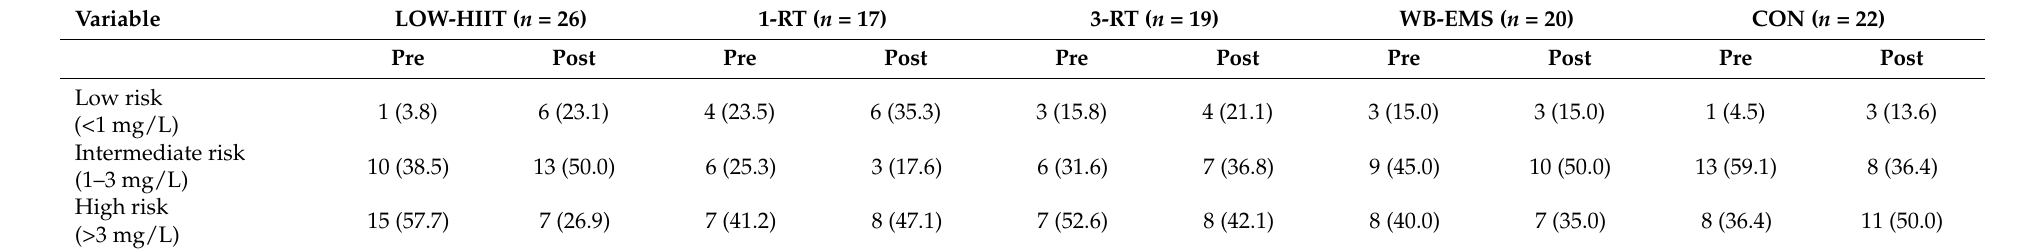
Table 5. Cardiovascular disease risk distribution related to hsCRP concentrations before and after the